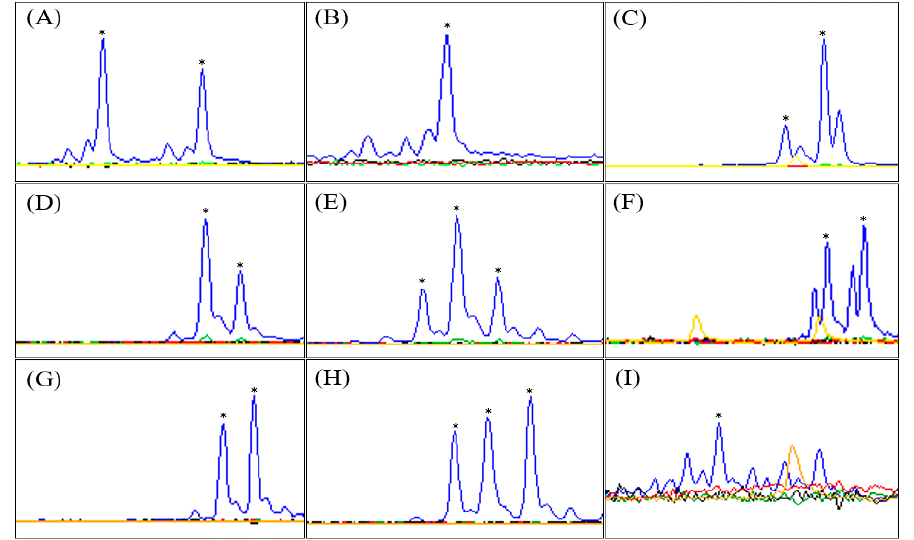
Figure 1. SSR profile generated through automatic capillary electrophoresis programming: Correct profile ( A ), excessive stuttering ( B ), weak alleles before ( C ), artefactual band ( D ), low heterozygosity peak ( E ), split peaks ( F ), null alleles ( G ), tri-allelic pattern ( H ), and noisy peaks ( I ). *, Correct alleles.